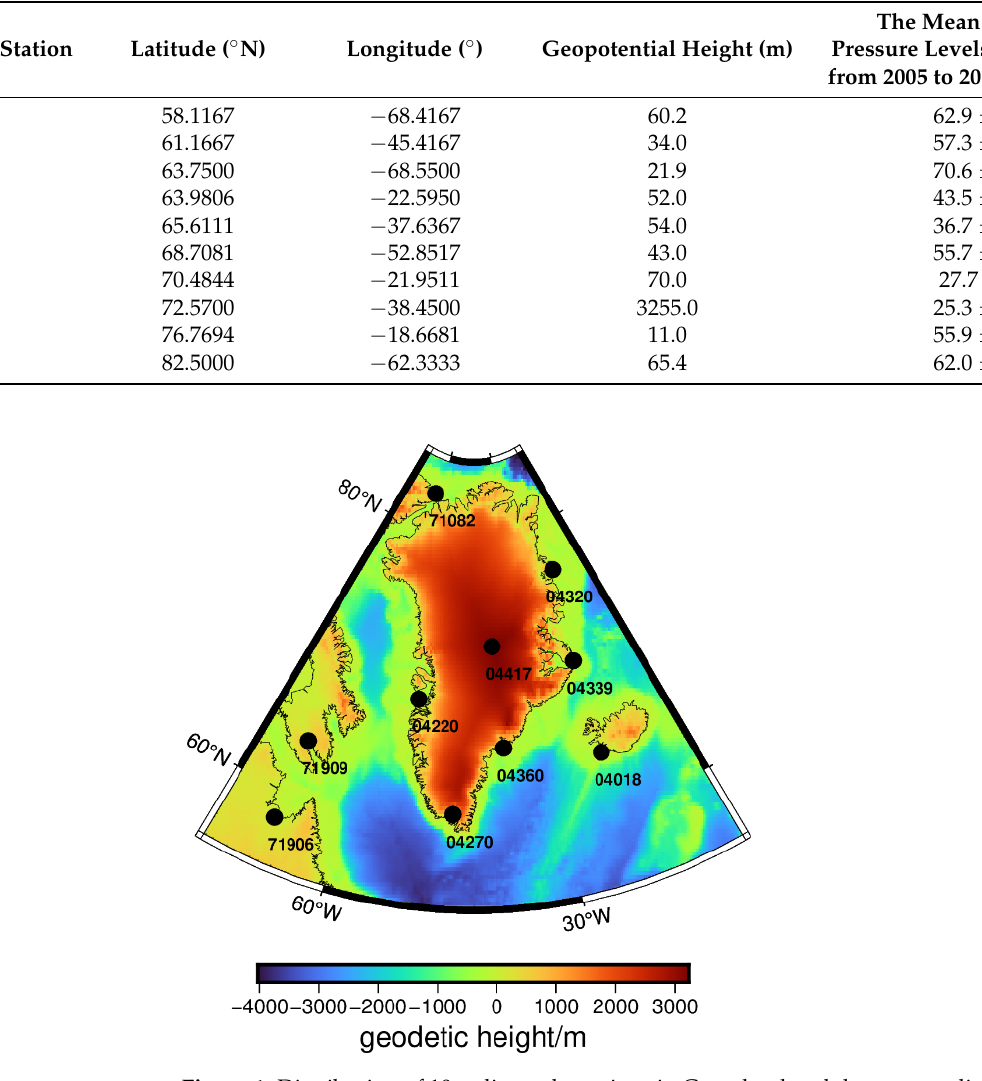
Figure 1. Distribution of 10 radiosonde stations in Greenland and the surrounding areas.